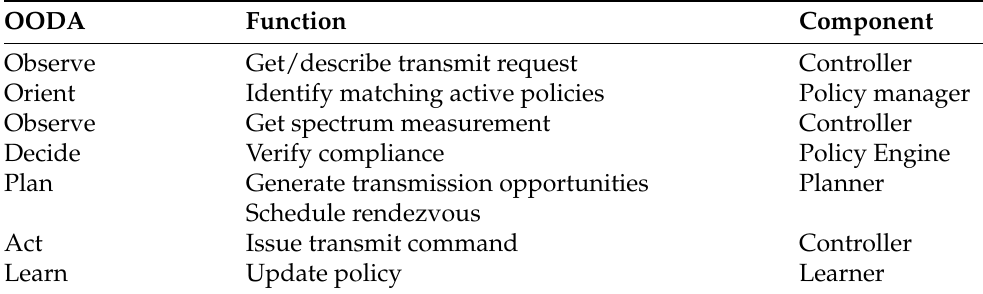
Table 1. Mapping the OODA loop to the Cognitive Radio Engine